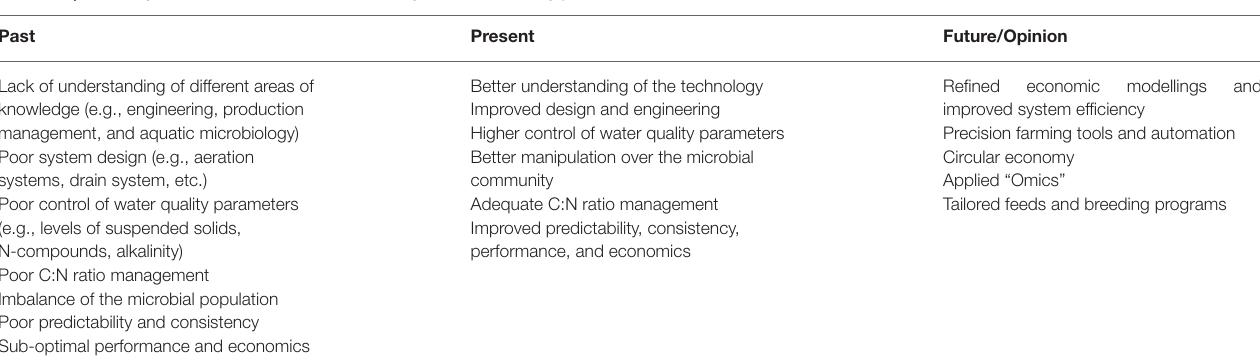
TABLE 1 | Summary of BFT evolution over time with key characteristics by